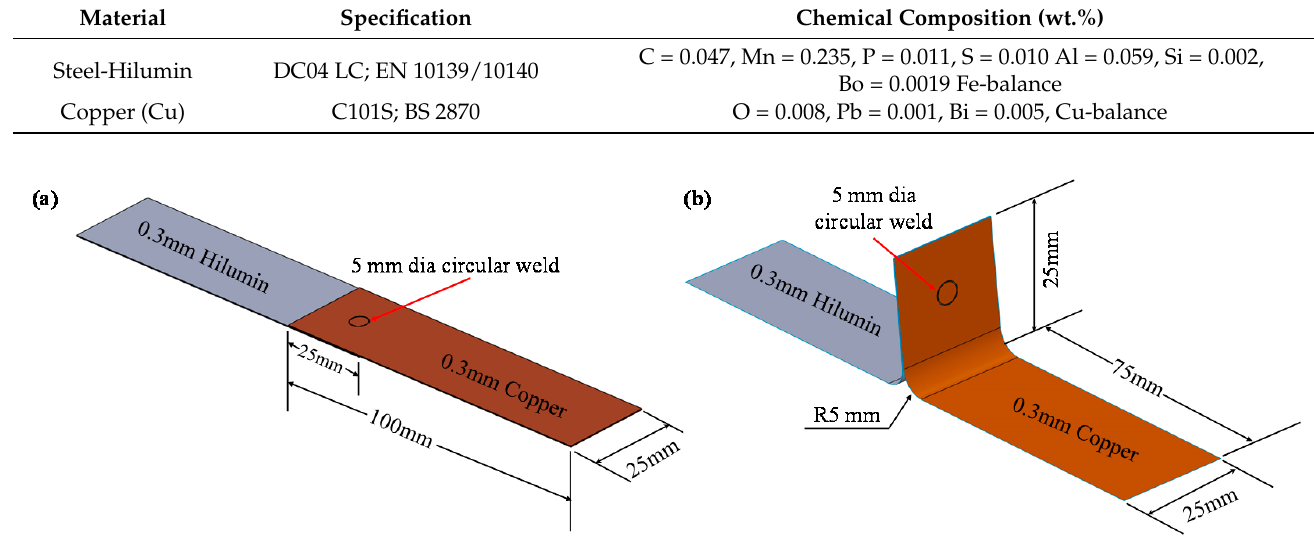
Figure 1. Schematic of micro-joint configurations having 5 mm diameter circular seam: ( a ) lap shear joint, and ( b ) T-peel joint.